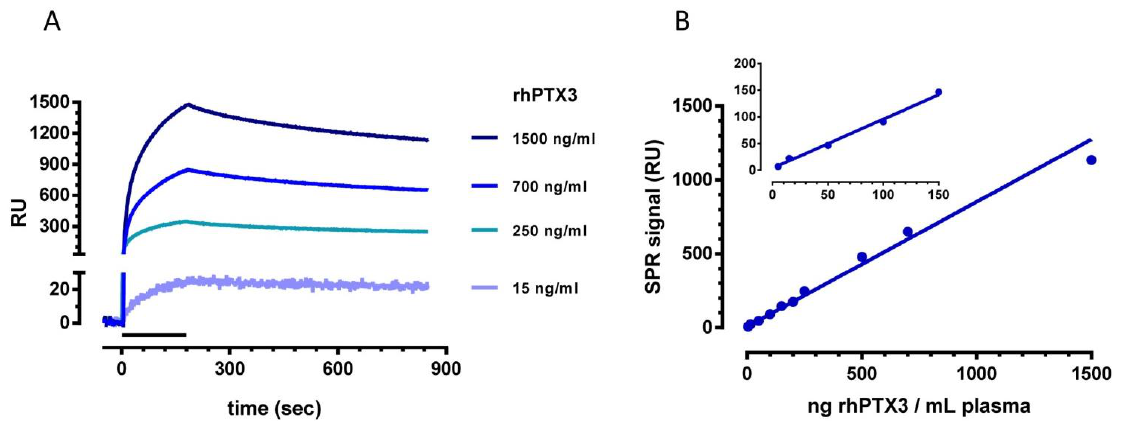
Figure 5. Linear correlation between the concentration of rhPTX3 and the SPR signal. Plasma of healthy subjects was spiked with different concentrations of rhPTX3 (5–1500 ng/mL), diluted five-fold in PBST, and injected for 5 min over the MNB4 immobilized antibody. Then, the pAbwas flowed for 3 min (bar) at a flow rate of 30 µL/min, over captured rhPTX3 and representative sensorgrams are shown in Panel A . Binding responses were subtracted of the signals detected on an empty surface, correcting for binding-independent responses such as bulk effects due to buffer exchanges or drift. (Panel B ) Calibration curve obtained plotting plasma rhPTX3 concentrations against the SPR signal at the end of the 10-min dissociation phase. The inset highlights the SPR signal obtained at the lower rhPTX3 concentrations.